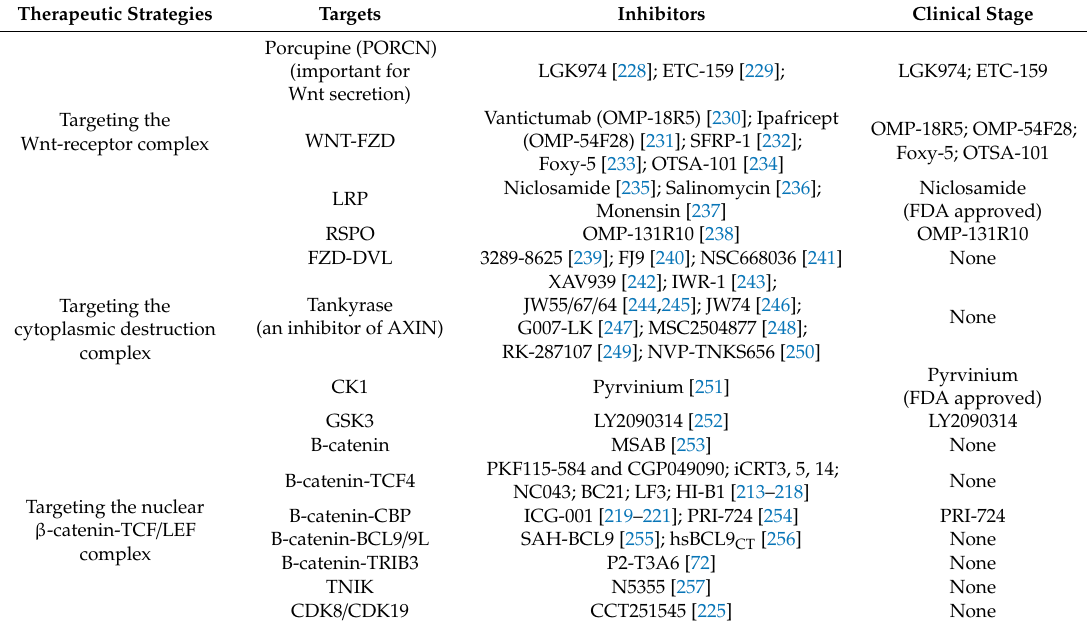
Table2. SummaryofpotentialtherapeuticstrategiesandinhibitorstargetingdysregulatedWntpathway. Therapeutic